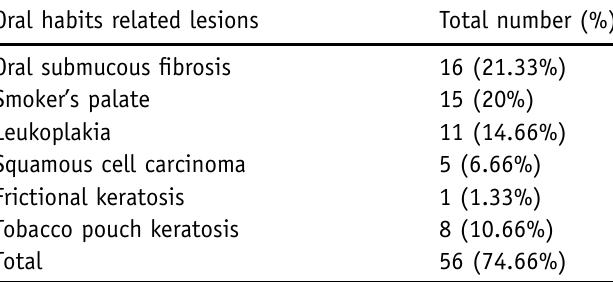
Table II. Prevalence of oral habits related lesions in the study participants.